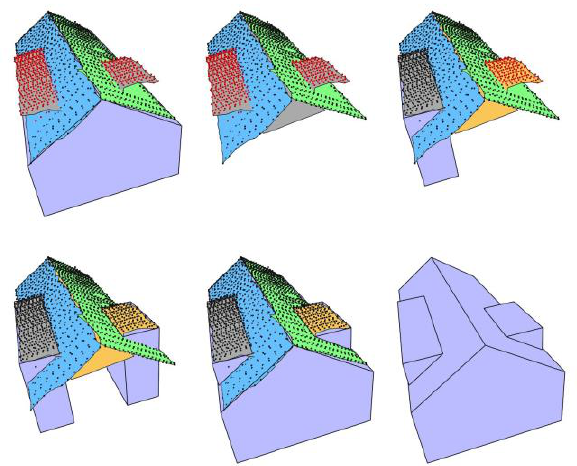
Figure 4. Example of segment splitting needed to model the two dormers originating from the same sub-surface